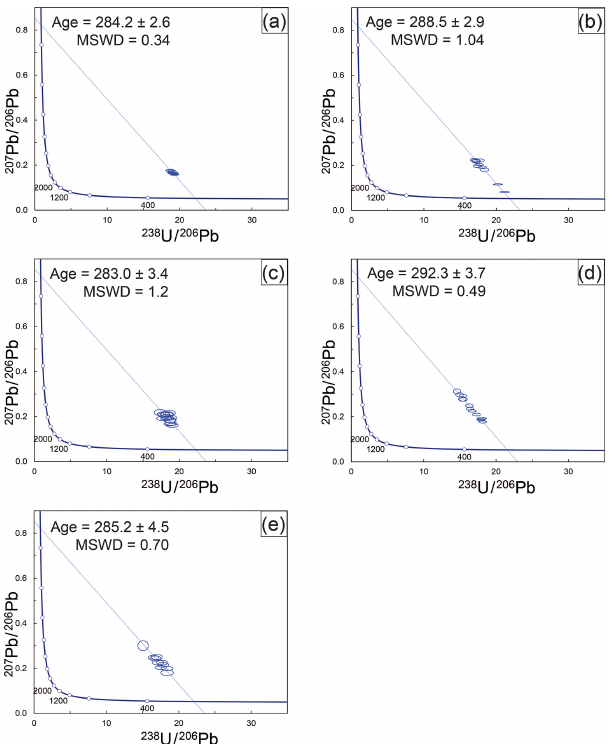
Figure B1. Tera–Wasserburg diagrams of allanite secondary stan- dards. (a) CAP b allanite, 14 June 2019 session; (b) CAP